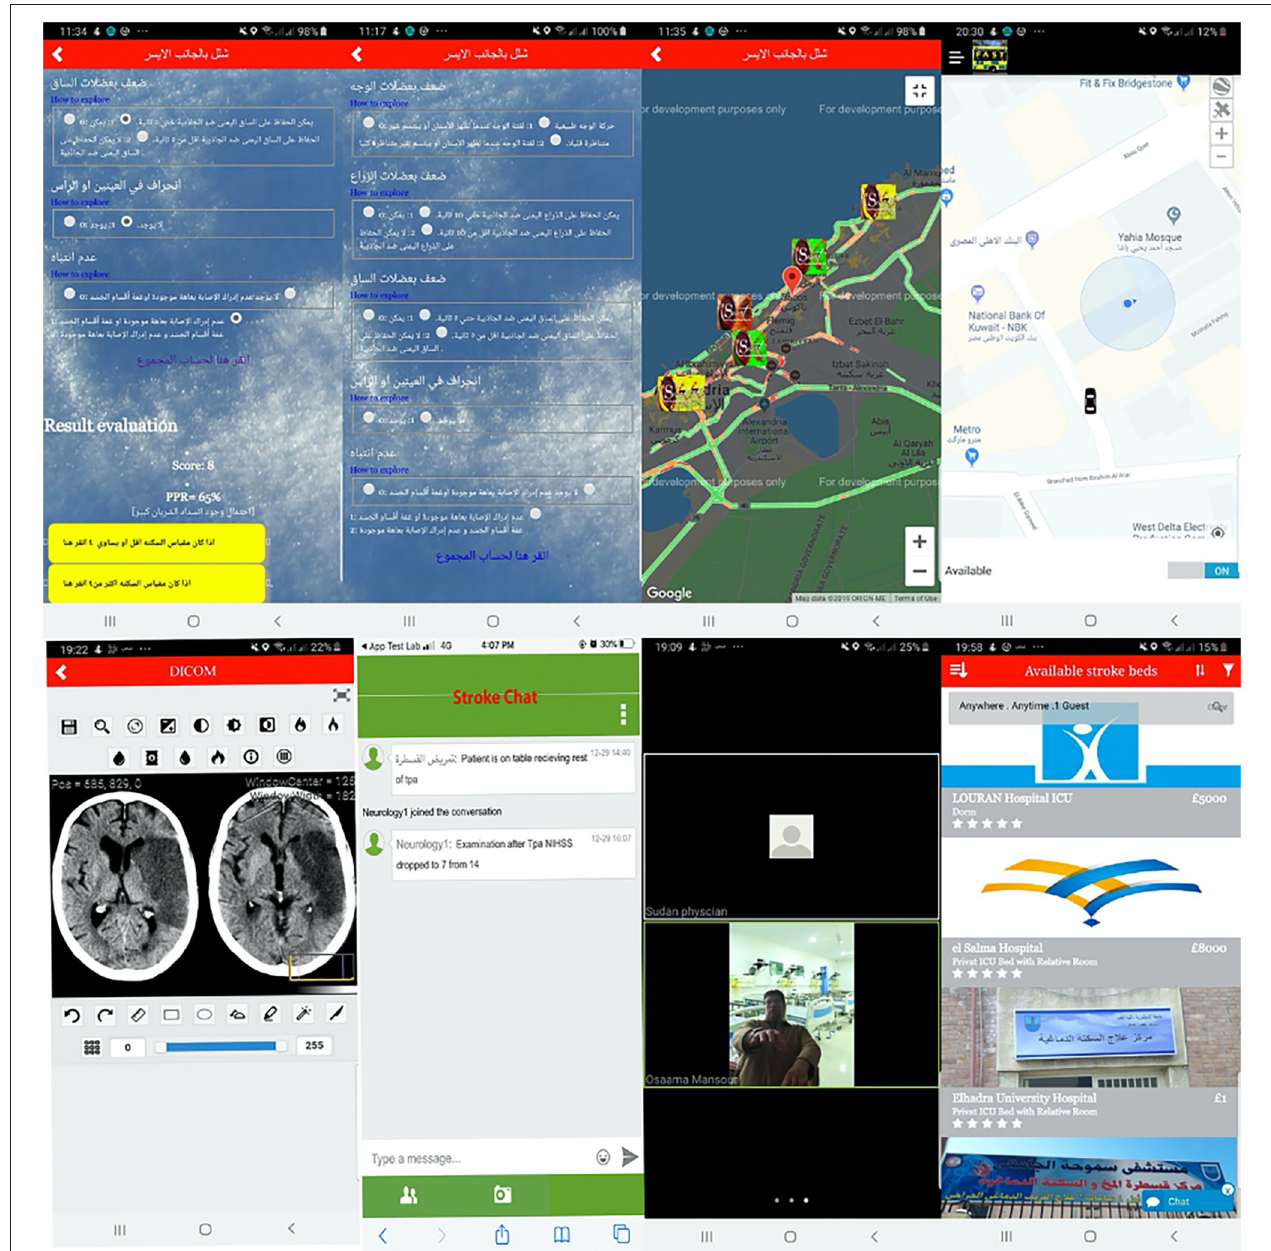
FIGURE 1 | Egyptian stroke network (ESN)-application